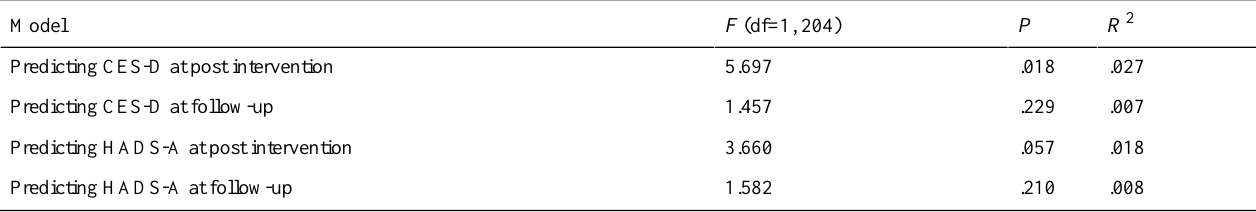
Table 5. Characteristics of the tested linear regression